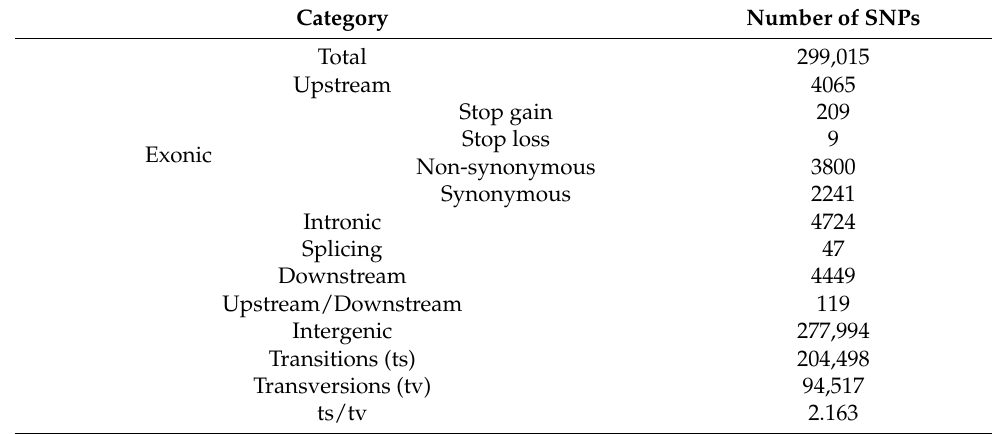
Table 3. SNP statistics and annotation results.